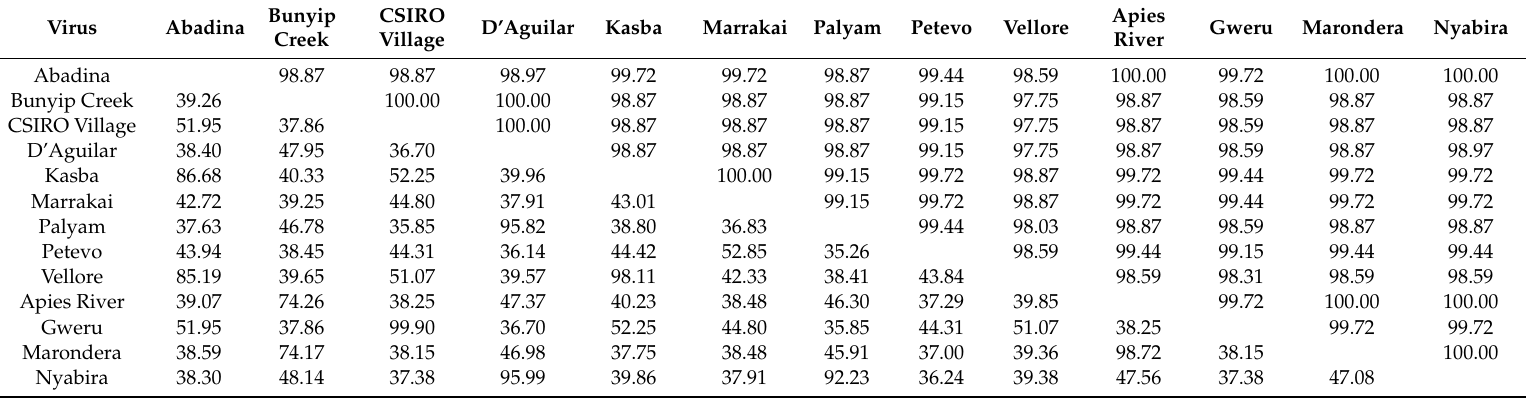
Table 3. Amino acid percentage identities for Segment 2 (VP2) on the bottom left and Segment 7 (VP7) on the top right.